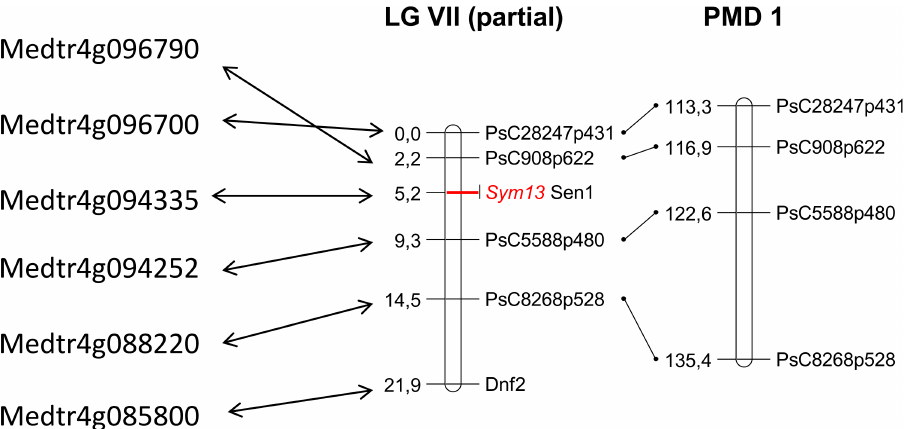
Fig 5. Localization of Sym13 gene in relation to gene-based markers. From left to right: names of M . truncatula genes homologous to pea markers used for Sym13 mapping,genetic map containing Sym13 , artificial map from